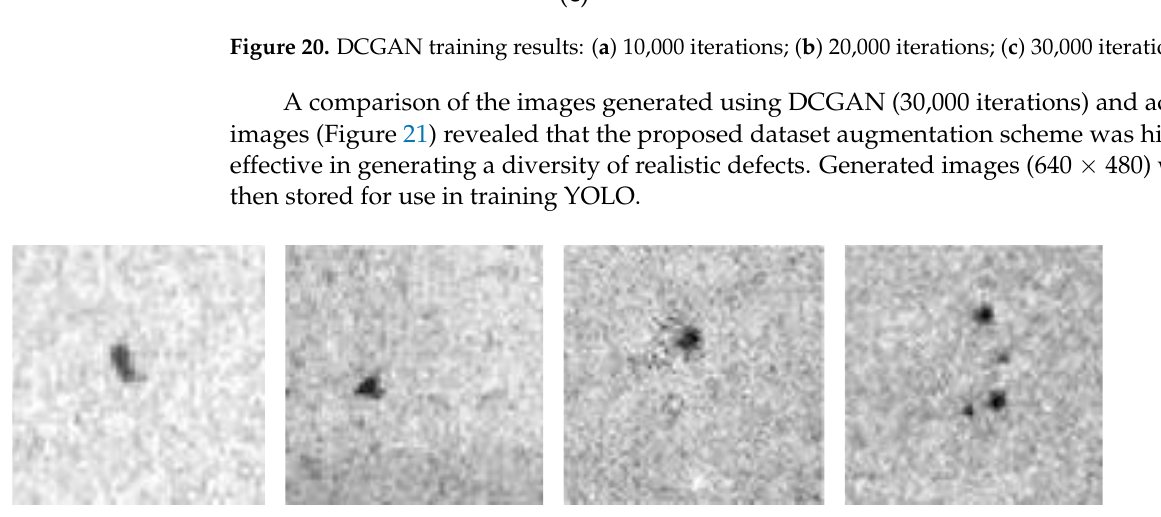
Figure 21. Comparison of actual photographic images and generated images.